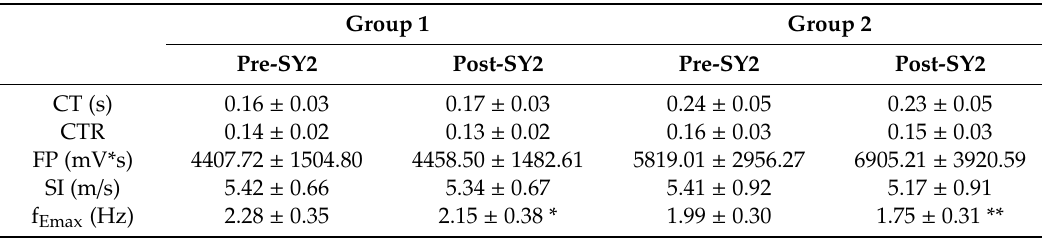
Table 2. Changes in parameters from PED for without/with SY2 attachment in the same group of testing subjects.